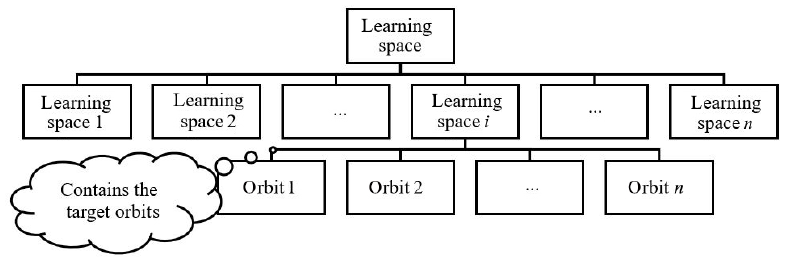
Fig. 6 Diagram of learning space, learning subspace, orbit, and target